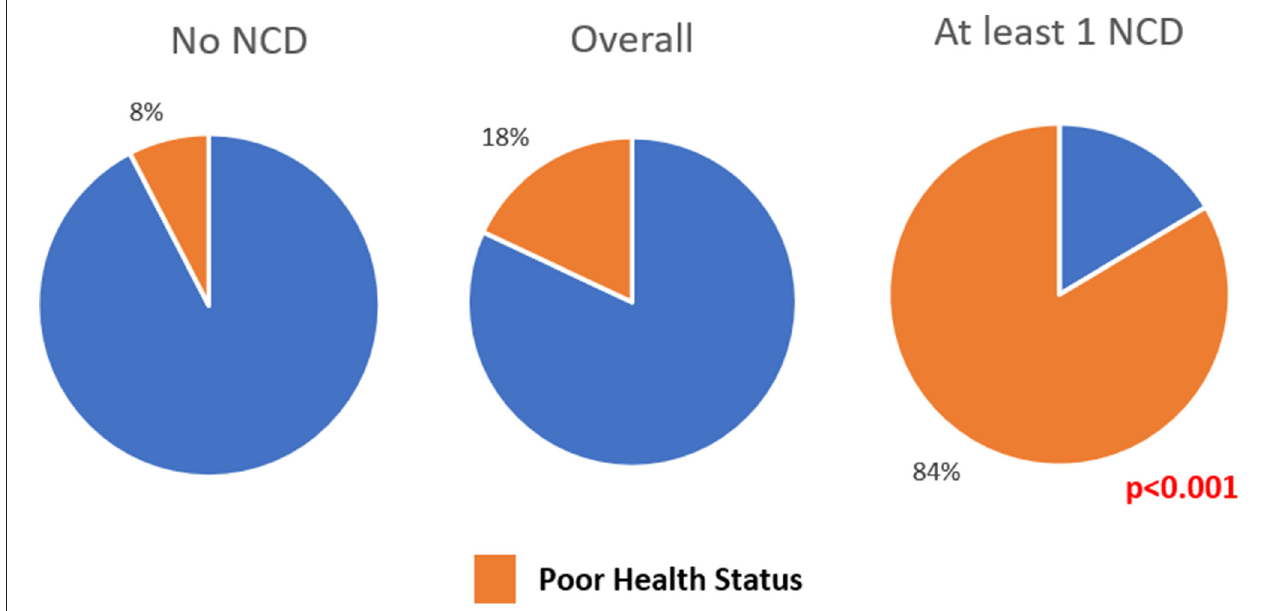
FIGURE 4 | Pie chart depicting the proportion of people reporting current health status as “poor” among adults residing in HDSS, Gorakhpur (overall, N = 75,037; no NCD, n = 65,152; at least 1 NCD, n = 9,885).